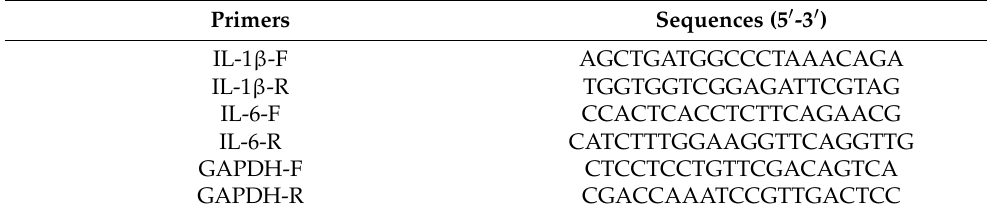
Table 1. Primers used in real-time quantitative PCR. F and R represent forward primer and reverse